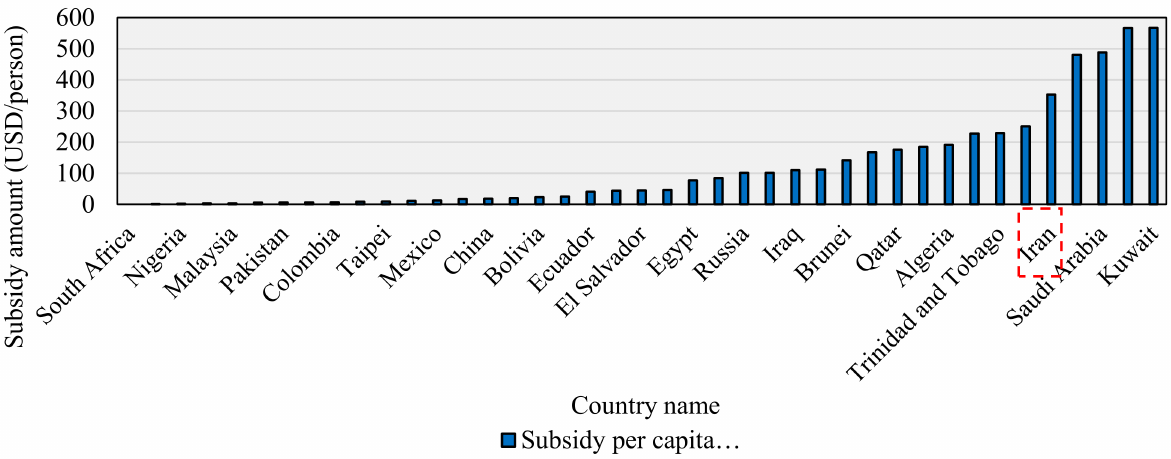
Figure 11. Subsidy of other countries and Iran per capita in